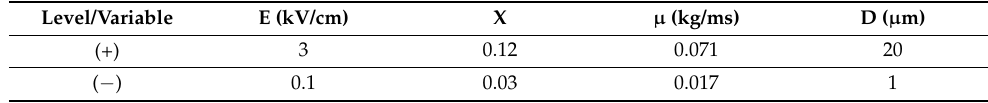
Figure 2. Optimal mesh design, after performing a grid sensitivity study, indicating a semi-structured grid with 3.4 million cells. Note that the mesh represents only half of the schematic shown in Figure 1 due to the symmetry of the system. Table 5. Levels of the parameters used in this study.